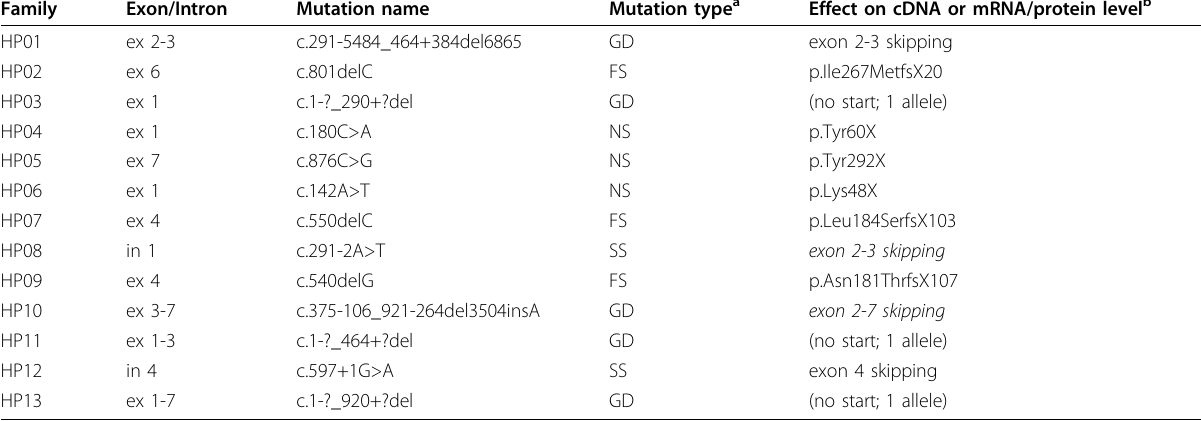
Table 2 Germline STK11 mutations in PJS patients